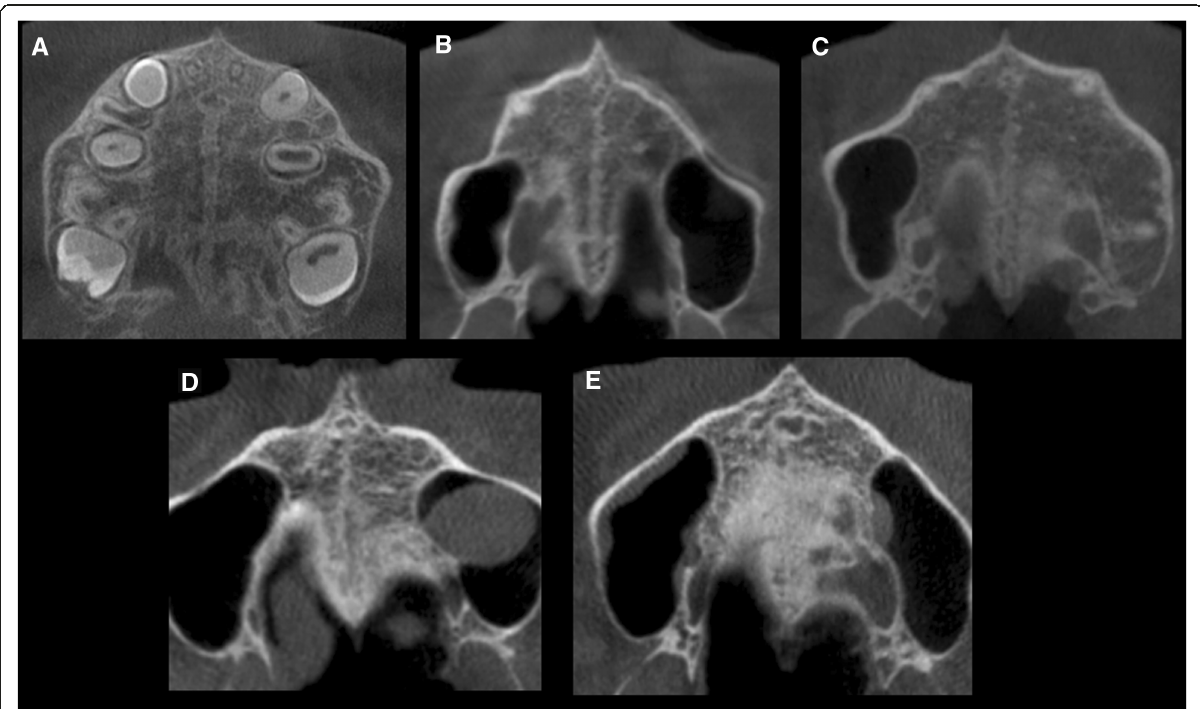
Fig. 2 Method of Angieleri et al. [15] in CBCT. a The midpalatal suture is seen as a relatively straight radiopaque line. b The midpalatal suture appears as a scalloped line of high density. c Two radiopaque, scalloped, and parallel lines are separated by areas of low radiographic density. d The palatine bones become more radiopaque, and the suture is not visualized in this sector only is visualized as two scalloped high-density lines at the midline on the palate bone. e It is no longer possible to see the suture along the maxillary and palatine bones, indicating fusion l; fusion has occurred in the